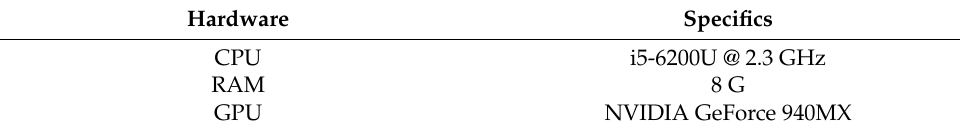
Figure 3. Test scene of fire evacuation. Table 1. Hardware specifics for rendering test.